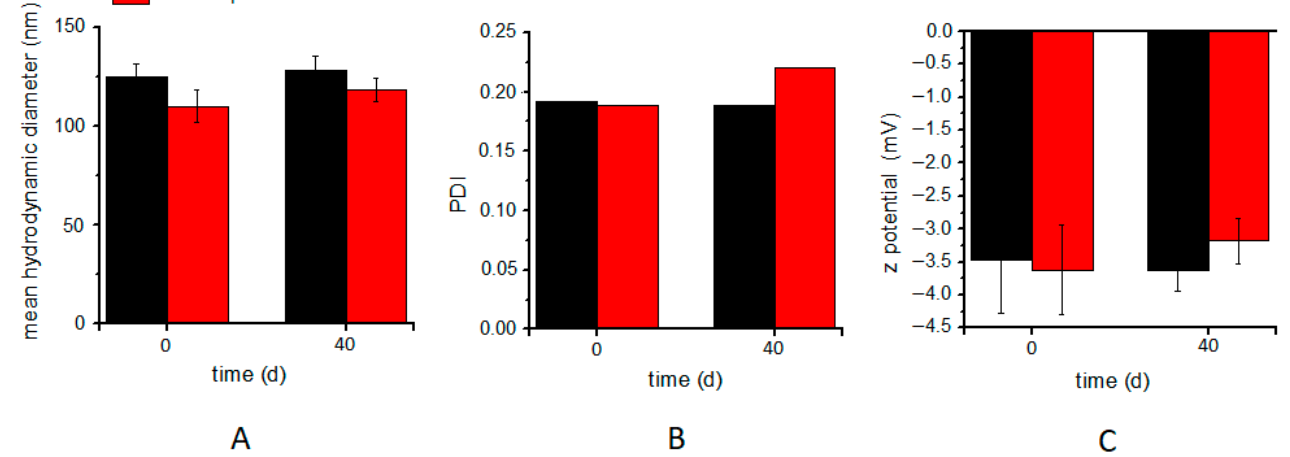
Figure 4. Vesicle mean hydrodynamic diameter (nm) ( A ), polydispersity Index ( B ) and ζ -potential (mV) ( C ) values of As-ether-lipid and As-Chol liposomes (they are the mean values from at least 5 measurements of 3 different preparations, in each case).